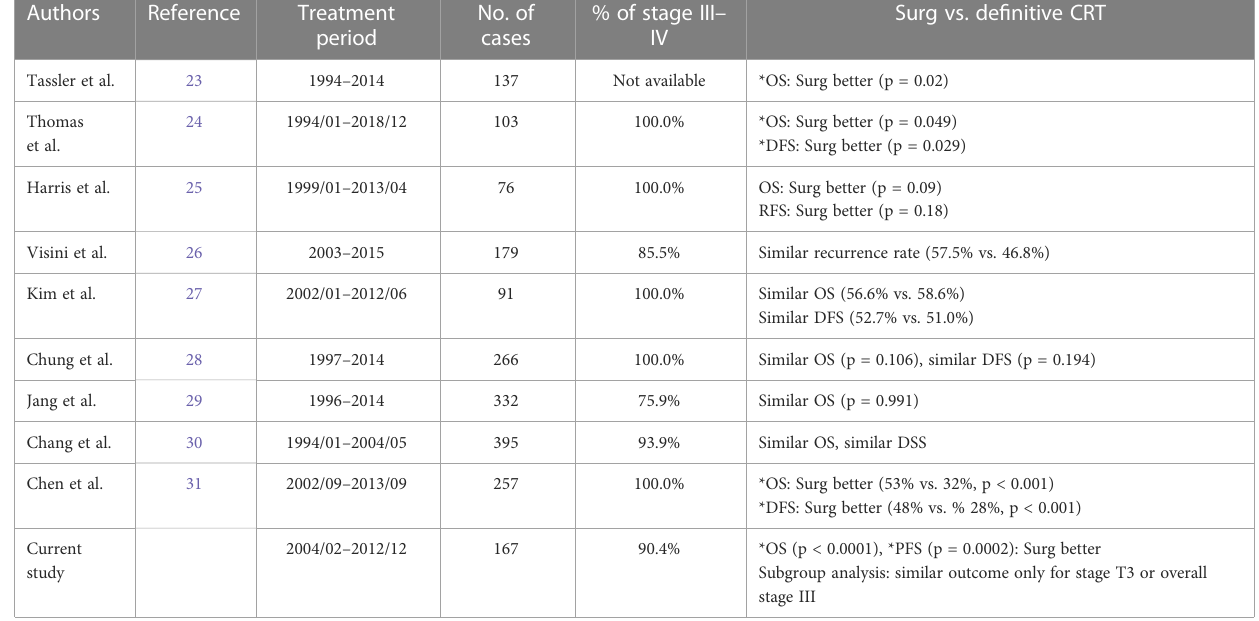
TABLE 4 Summary of retrospective observational studies comparing surgery-based therapy versus de fi nitive chemoradiotherapy.